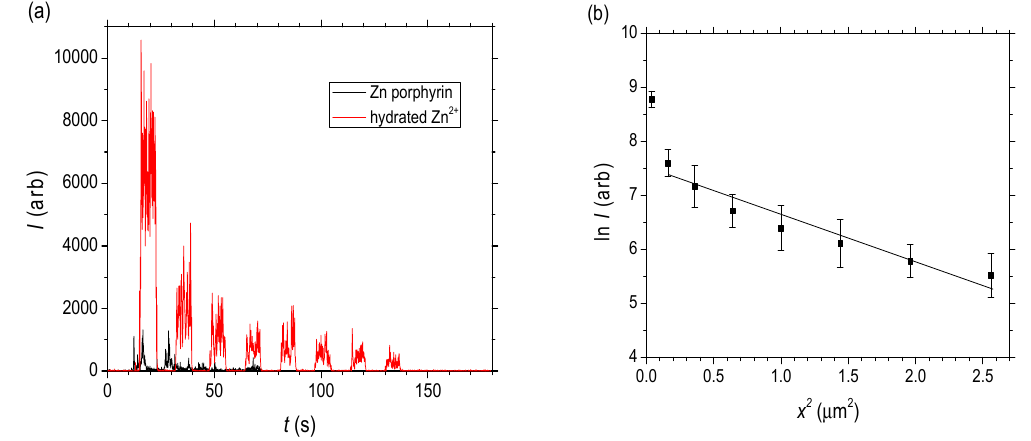
Figure 6. Laser ablation-inductively coupled plasma-mass spectrometry (LA-ICP-MS) of self-assembled wires doped with ZnTPP and zinc acetate solutions ( c ( a ) Signal intensity as a function of each ablation over time for both molecules and ( b ) Diffusion analysis (natural log of signal intensity vs. area) of the hydrated Zn 2+ from the zinc acetate